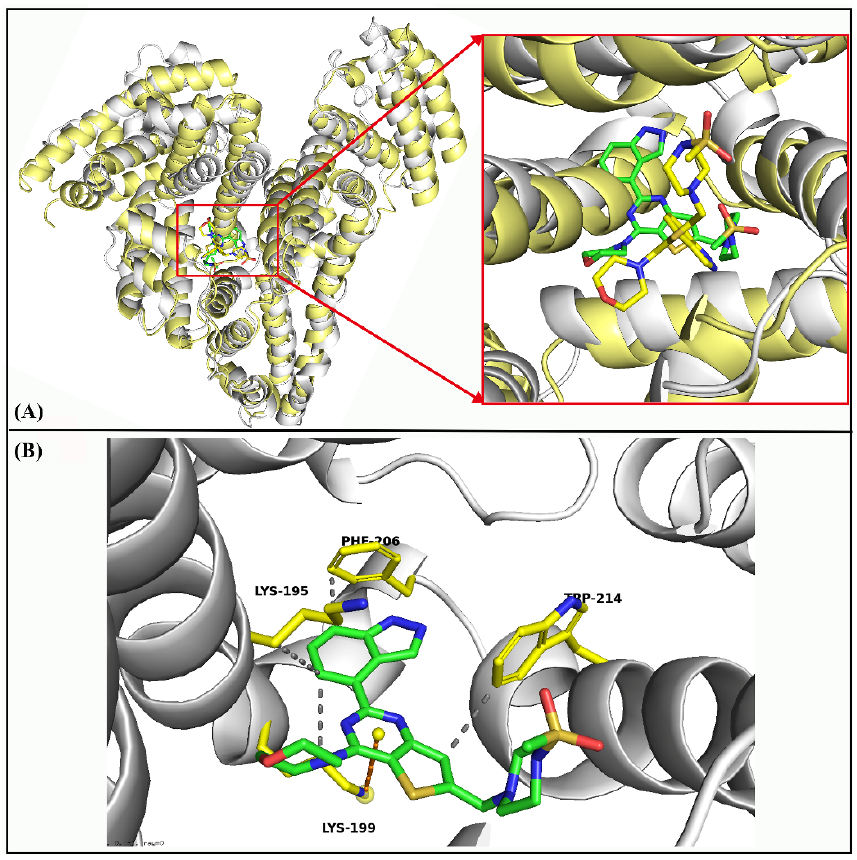
Figure 4. ( A ) Comparison of binding conformation between GDC-0941 and HSA before and after MD simulations of 95 ns. ( B ) The most stable conformation of the HSA–GDC-0941 complex system at 95 ns (hydrophobic interactions are depicted in gray and π –cation interactions in orange). Table 2. Detailed information of interaction forces in HSA–GDC-0941 complex at 95 ns.